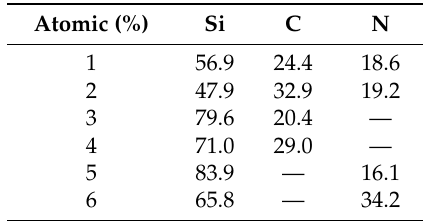
Figure 15. TEM images and electron diffraction patterns of sample C synthesized at 1550 °C (Si:C = 1:1.5): ( a , b ) SiCN,( c ) SiC and ( d ) Si 3 N 4. Table 6. EDS analysis results of samples (at %).